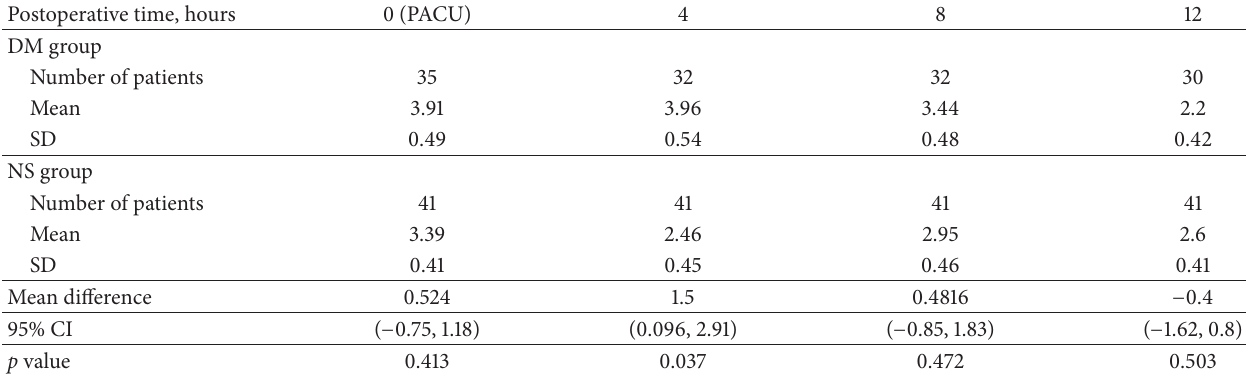
Table 2: VAS scores for pain intensity during the first 12h postoperatively.